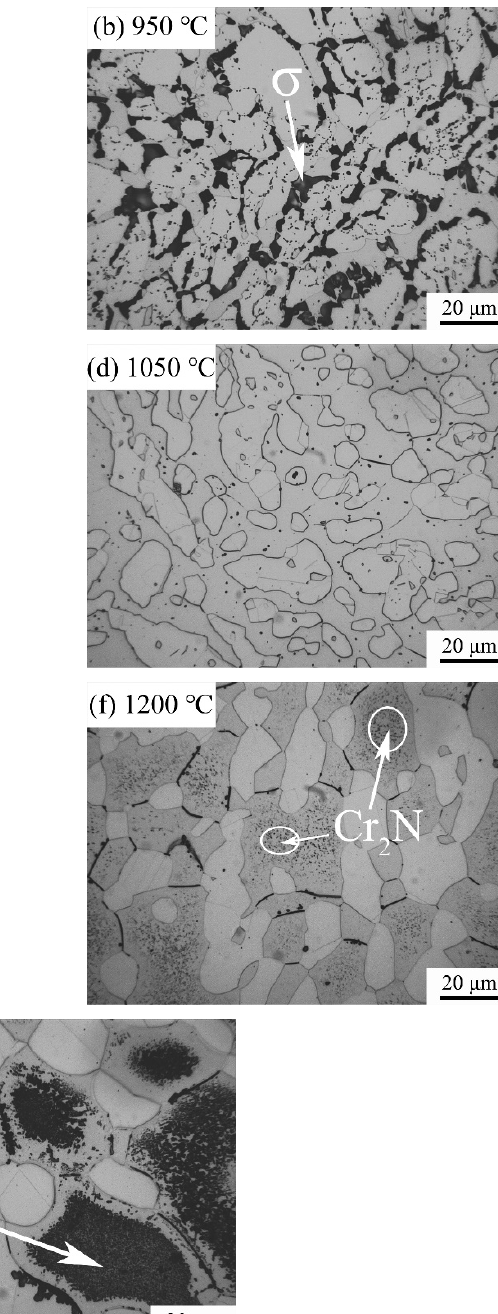
Figure 7. Metallographic picture of precipitated phase morphology at different solution treatment temperatures. ( a ) 900 °C; ( b ) 950 °C; ( c ) 1000 °C; ( d ) 1050 °C; ( e ) 1100 °C; ( f ) 1200 °C; and ( g ) 1300 °C.